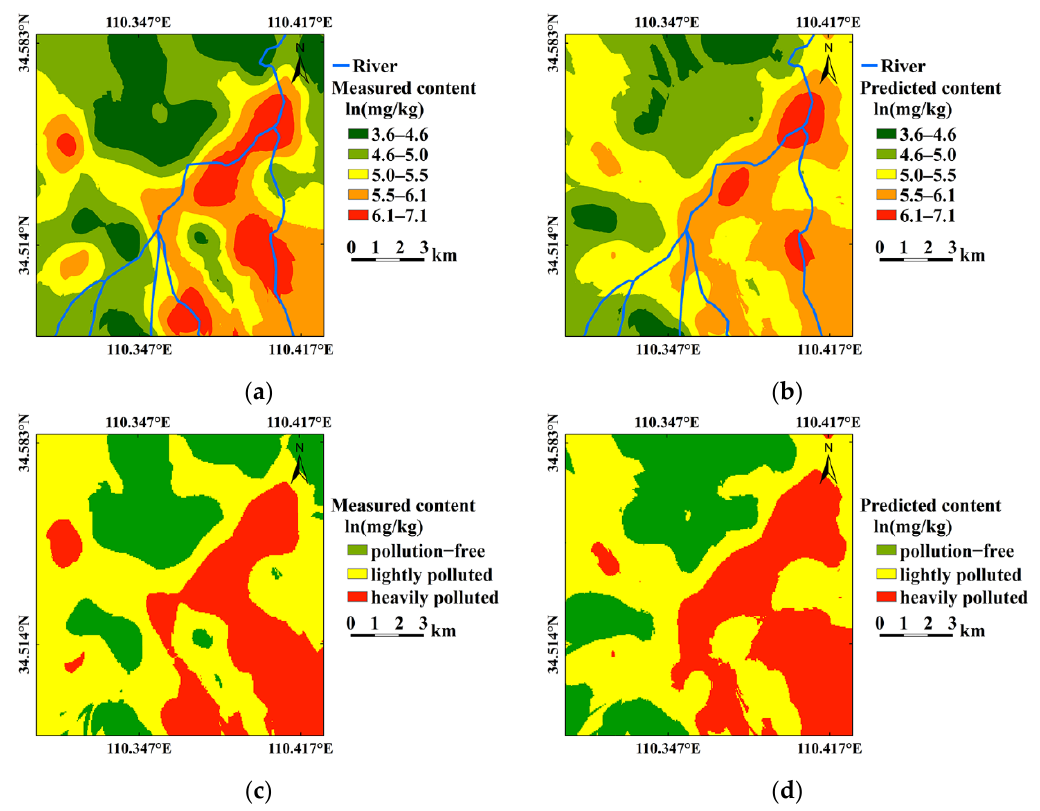
Figure 7. Mapping the distribution of Pb contamination in soil generated by OK at equal intervals based on ( a ) the measured data, ( b ) predicted data. The categorical maps following government standard are shown as ( c ) for the measured data and ( d ) for predicted data.